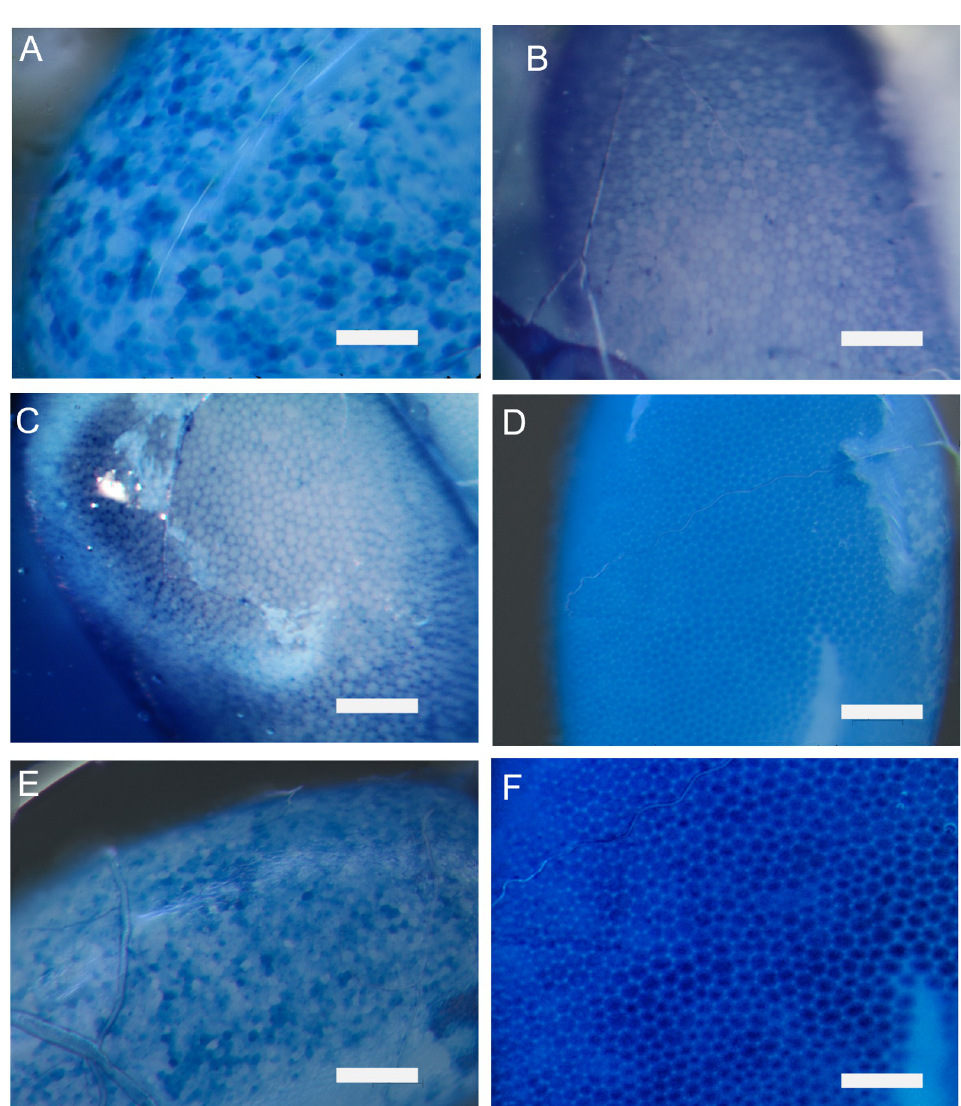
concentrations of 10 − 3 M. The white scale bar corresponds to 100 μ